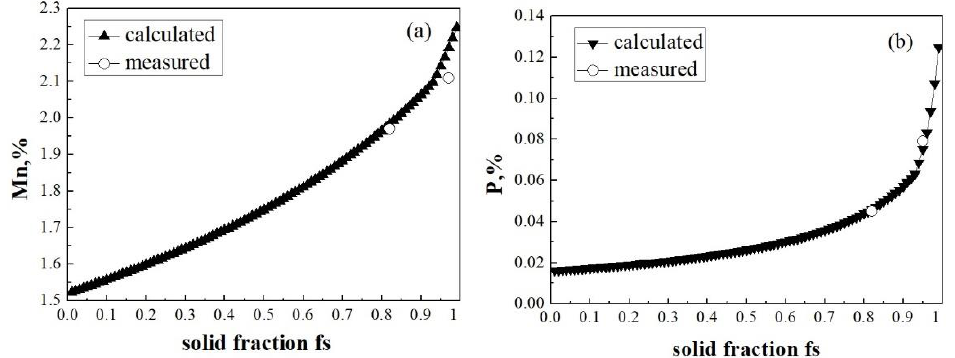
Figure 1. Comparison of ( a ) manganese and ( b ) phosphorus concentration in the liquid phase calculated and experimental measurements.